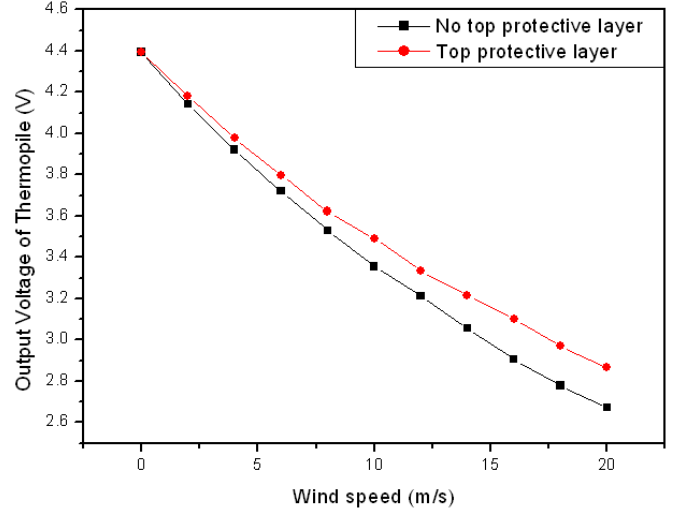
Figure 9. Wind speed measurements of the sensor with and without the two-layered upper protective coating. Table 2. Comparison of specification conditions (no top protective layer/top protective layer).